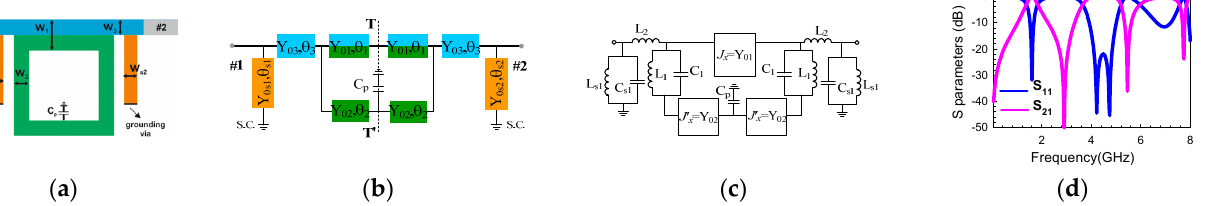
Figure 5. ( a ) A bandstop filter circuit by using a square loop resonator with perturbation element and open-circuited stubs ( b ) TL model ( c ) LE model ( d ) frequency response.